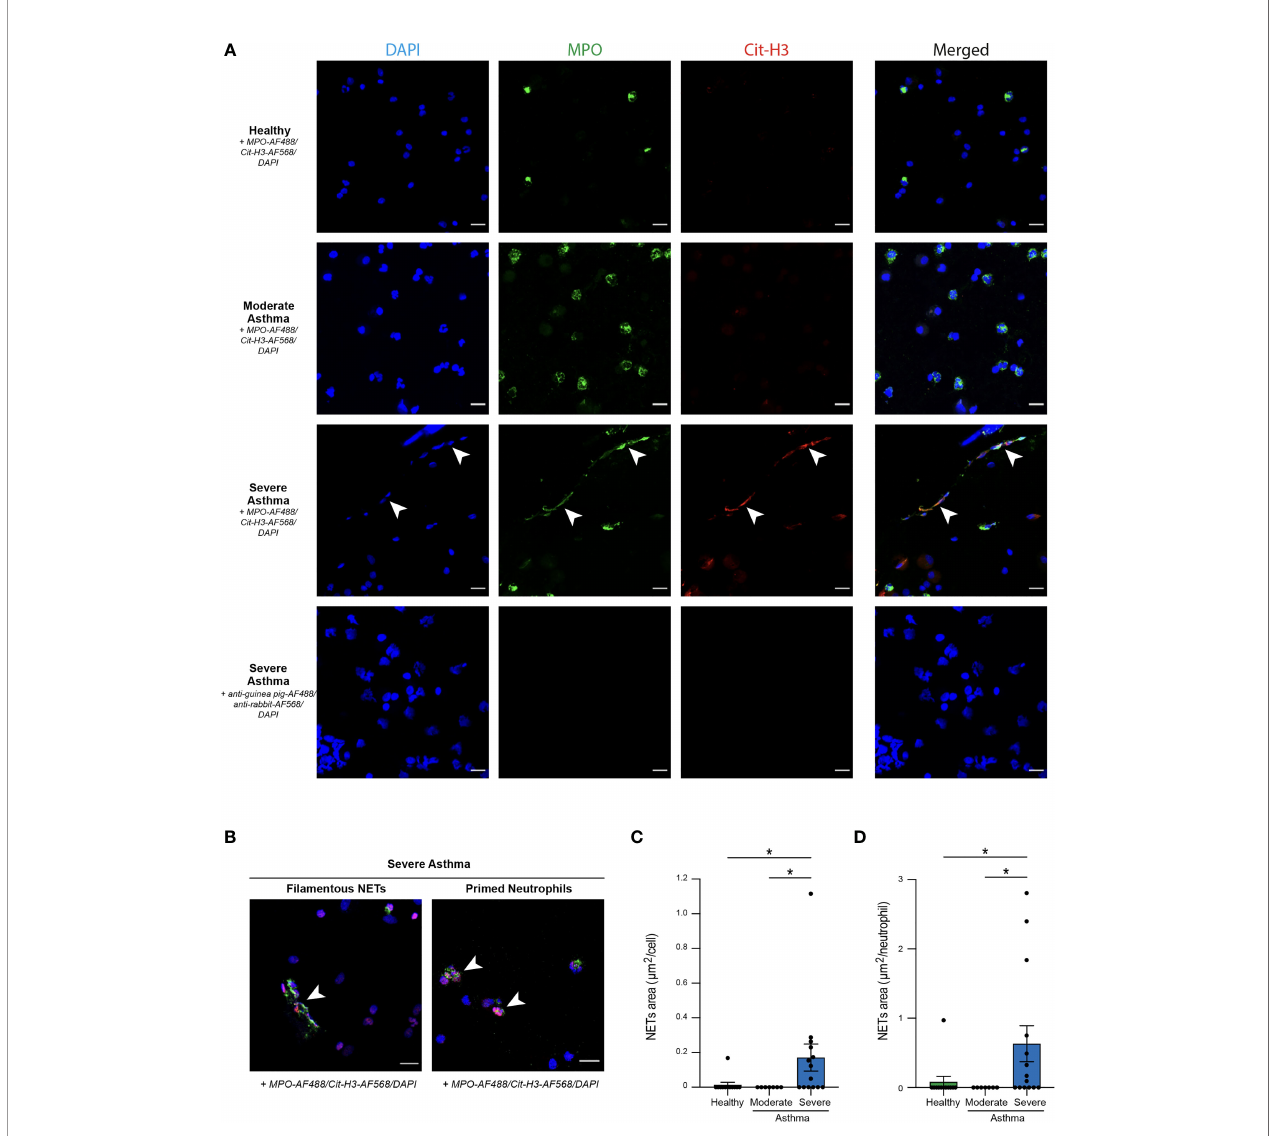
FIGURE 3 | Propensity of BALF neutrophils to release NETs in severe asthmatic horses. (A) Representative confocal microscopy pictures of BALF cytospins stained with anti-MPO and anti-Cit-H3 antibodies, and DAPI. NETs are extracellular structures staining double positive for MPO and Cit-H3 and are indicated by white arrows. (B) Representative pictures of fi lamentous NETs and “ primed ” neutrophils present in BALF of severe asthmatic horses. (C) NETs quanti fi cation in BALF cytopsins expressed as NETs area per cell. (D) NETs quanti fi cation in BALF cytospins expressed as NETs area per neutrophil. Data show mean+/-s.e.m., as well as individual horses (healthy n=12; moderate asthma n=7; severe asthma n=14). P values were estimated with a one-way ANOVA with Kruskal-Wallis ’ post hoc test. * , P < 0.05. (A, B) Scale bar = 20 µm; objective: